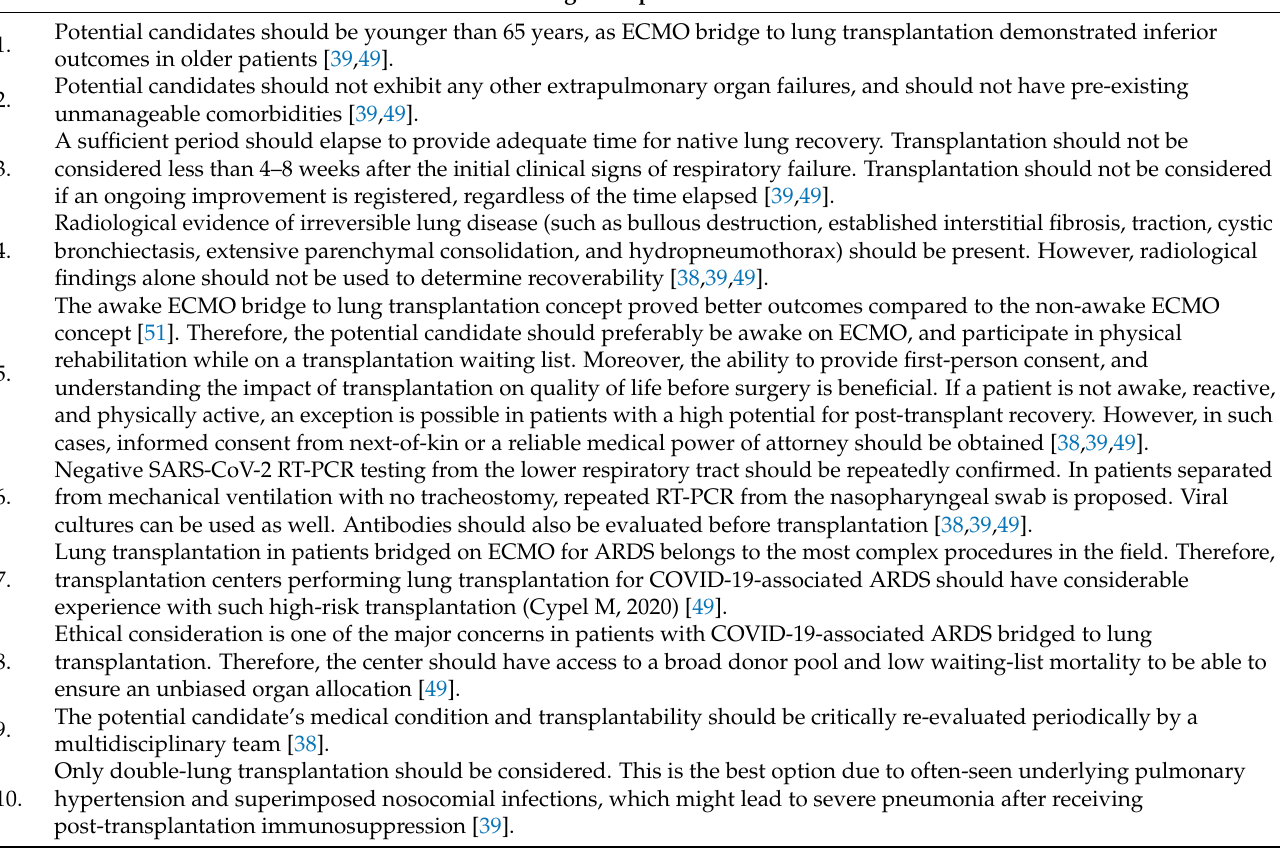
Table 1. COVID-19-associated ARDS recipient evaluation—major aspects to be considered in candi- dates for lung transplantation based on available